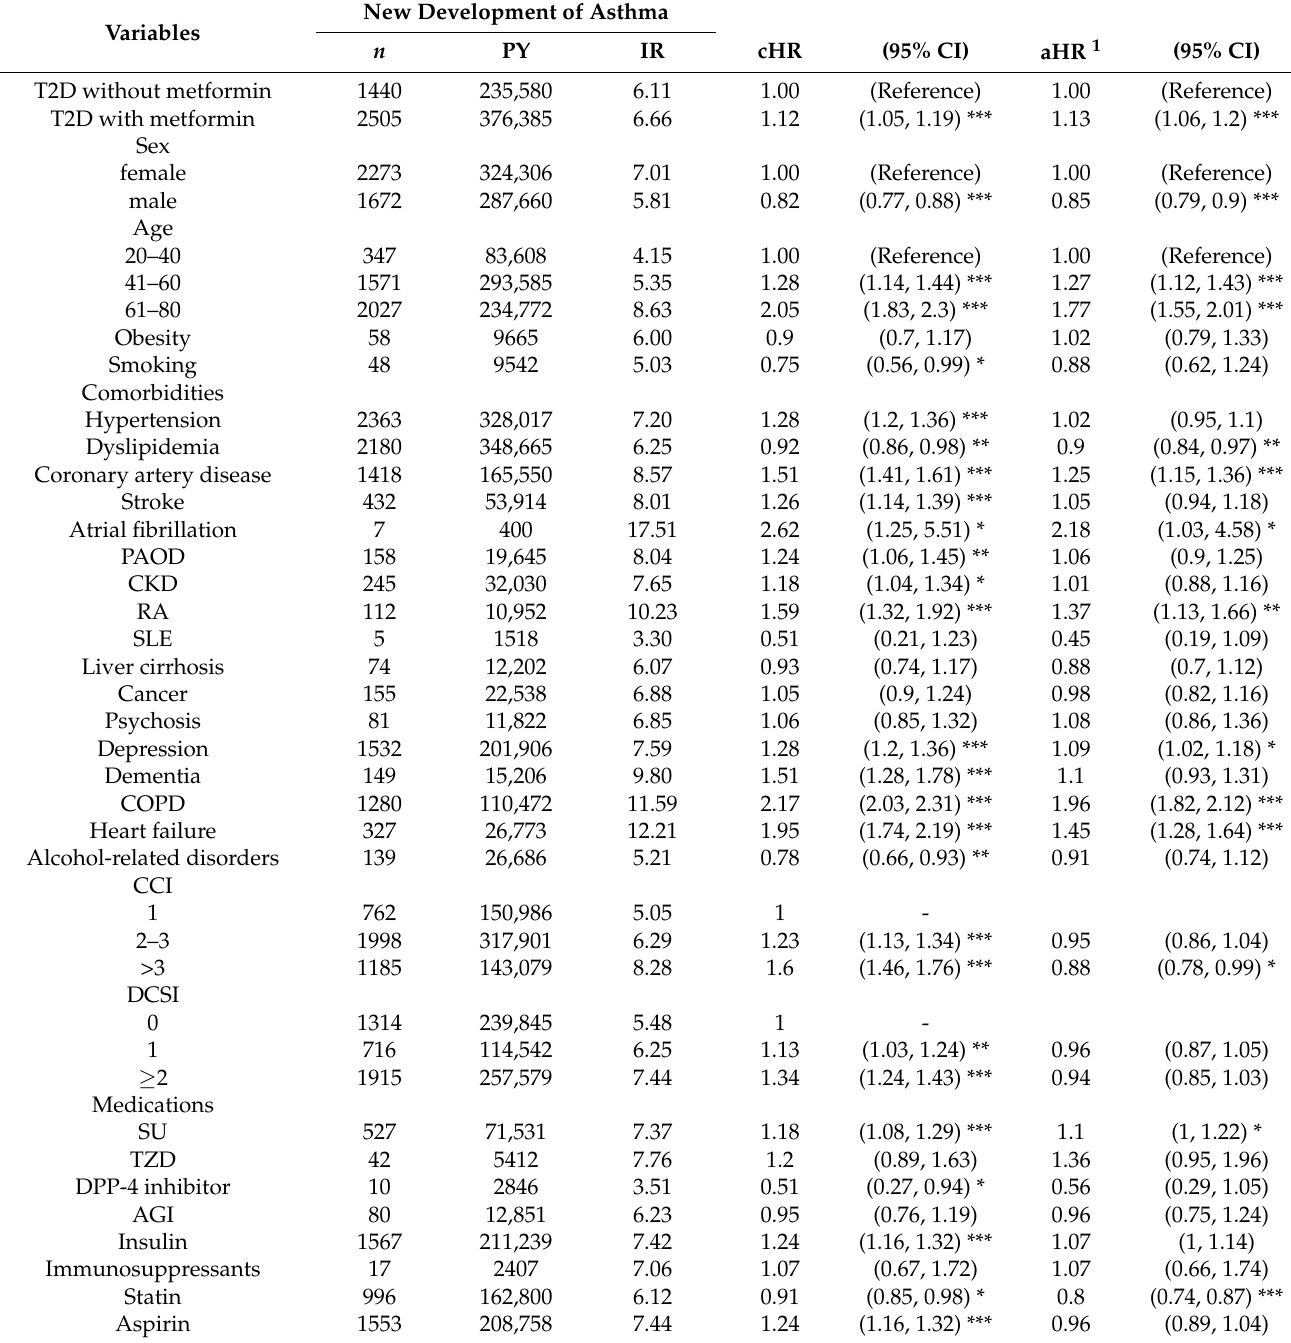
Table 2. Variables and the risk of asthma